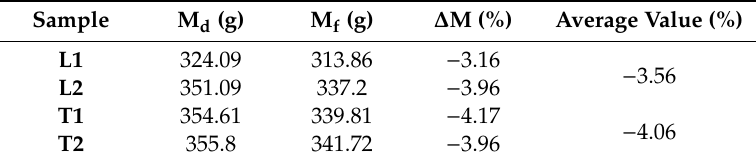
Table 9. Results obtained from the resistance to salt crystallisation test.